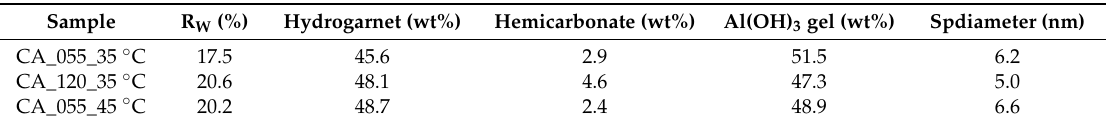
Table 2. Selected results for the synchrotron PDF analysis of the calcium aluminate pastes in the 1.5–70 Å